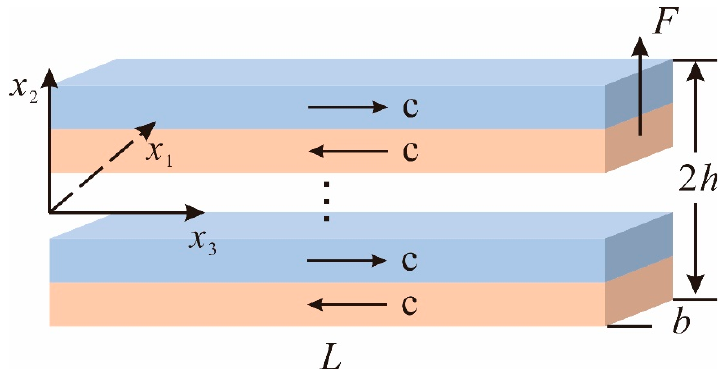
Figure 1. A multilayered ZnO beam with alternating opposite polarization directions along the thickness direction.